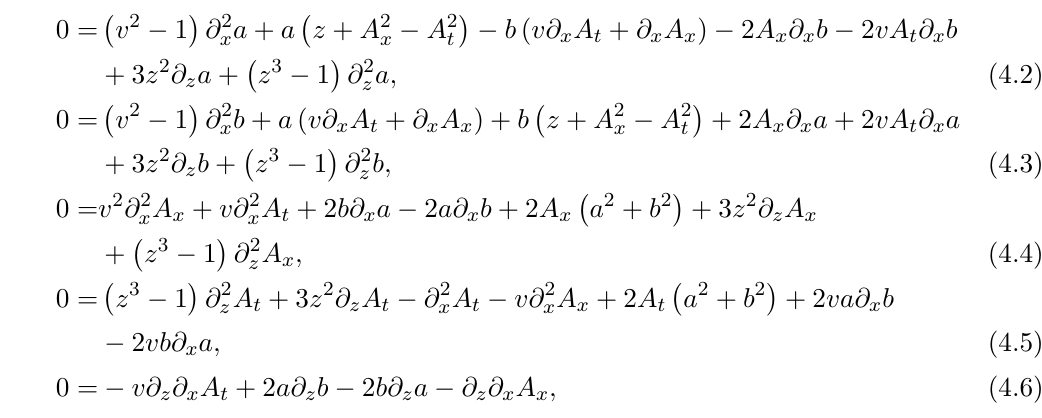
Figure 10 . The order parameter jh O ij distributions at di(cid:11)erent speeds ( v = 0 ; 0 : 2 ; 0 : 4 ; 0 : 6 ; 0 : 66 ; 0 : 7) of gray solitons with the chemical potential (cid:22) = 5 : 5 at standard quantization. The values of jh O ij x =0 are in sequence 0, 0.0443334, 0.204758, 0.644198, 0.897435, 1 with the increasing velocities. are written